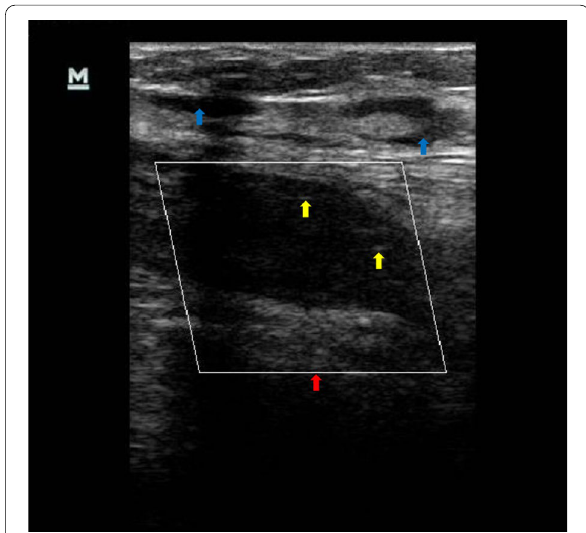
Fig. 7 An ultrasound image of the left lower limb performed for a 61‑year‑old woman who reported with a three‑day history of swollen left lower limb and calf pain. It shows multiple intraluminal hyperechoic lesions (yellow arrows); no flow was noted within the distal third of the thigh vein (deep femoral) on color Doppler interrogation (red arrow) and associated multiple rounded inguinal lymphadenopathies as shown by the blue